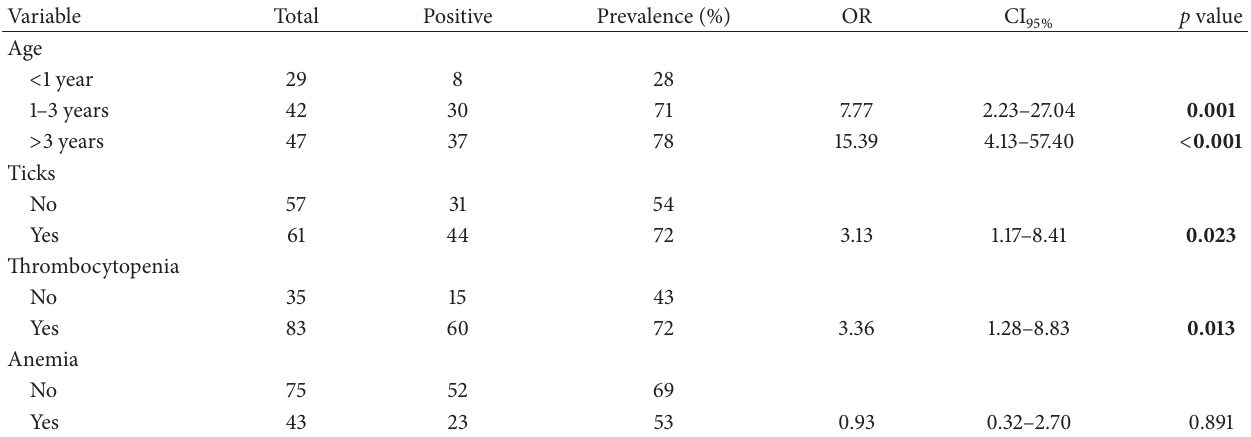
Table 1: Logistic regression analysis to detect associated factors to anti- Ehrlichia spp. antibody response in 118 dogs from Xcalak, Quintana Roo,